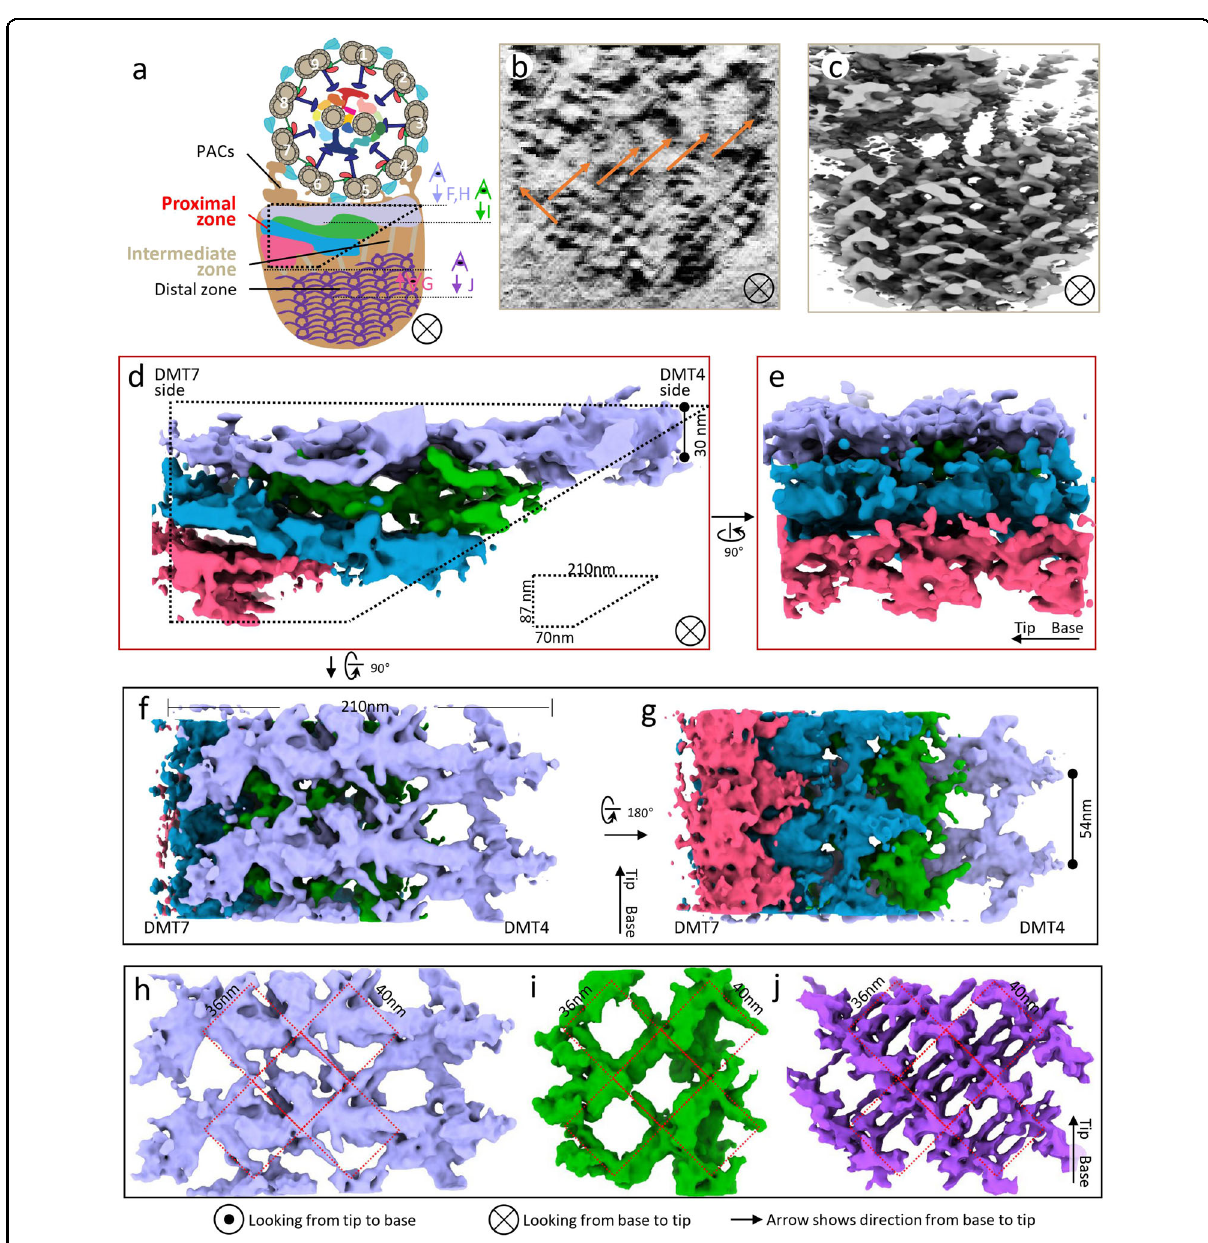
Fig. 4 Structure of the proximal zone and its structural continuity with the intermediate and distal zones. a A schematic illustrating the location of the trapezoid-shaped proximal zone with respect to the rest of the fl agellum. b , c Cross-section density slice (10 nm thickness) from a single tomogram ( b ) and the surface view of the same region after sub-tomographic averaging displayed at a low-density threshold ( c ). The connecting densities of the intermediate zone (arrows in b ) contact wires of the distal zone. d – g Cross-section ( d ), side ( e ), top ( f ), and bottom ( g ) surface views of the trapezoid-shaped proximal zone after sub-tomographic averaging. The four density layers distinguishable by gaps are colored differently. Viewing angles are shown in a . h – j Top views of the light purple ( h ) and green ( i ) proximal zone layers, alongside the same view of the distal zone ( j ), highlighting the contiguous 36 by 40 nm lattice pattern (red) in all